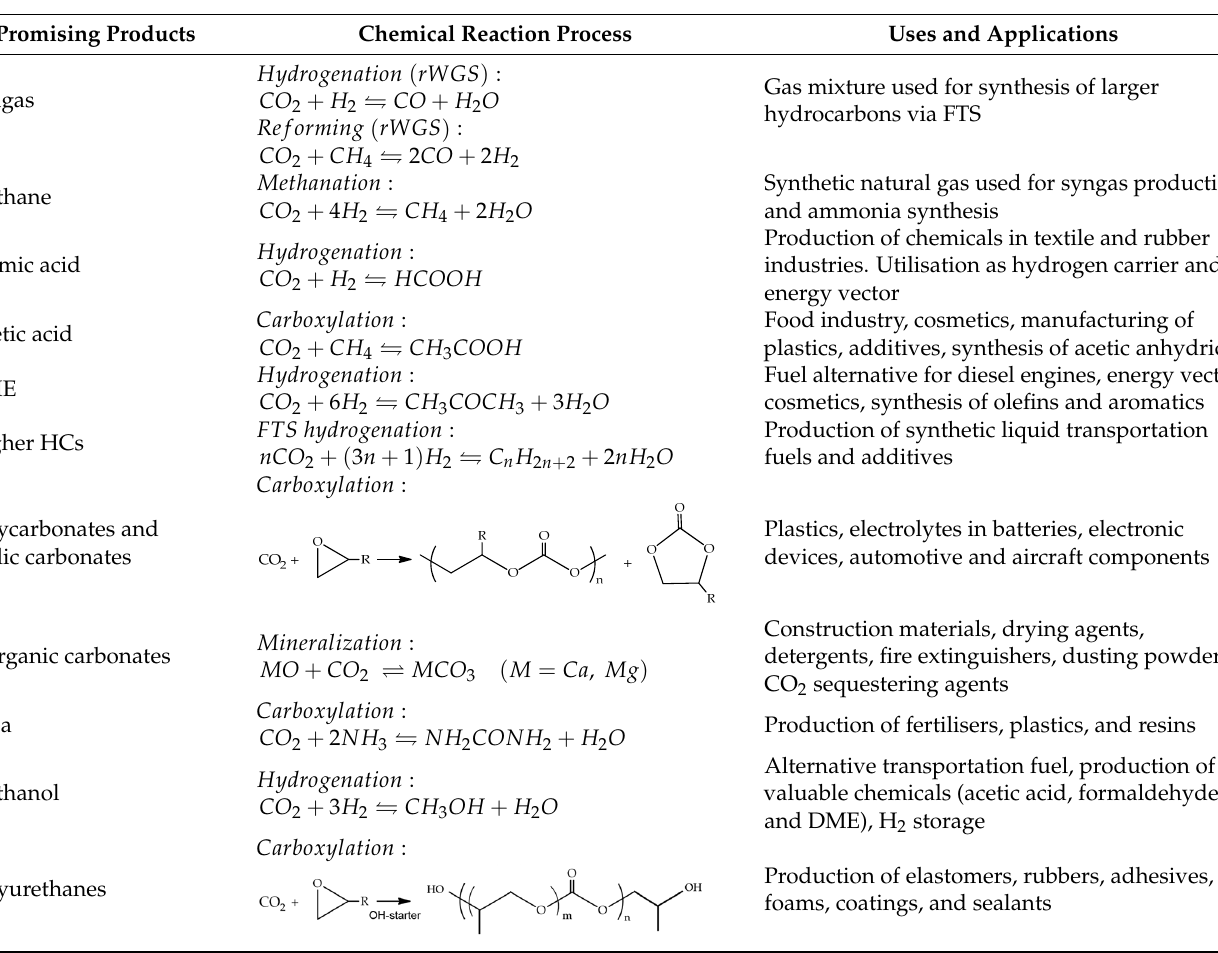
Table 2. Chemical reactions and usages for some relevant valuable products derived from CO 2 as chemical feedstock. Adapted from reference [82]. Chemical Reaction